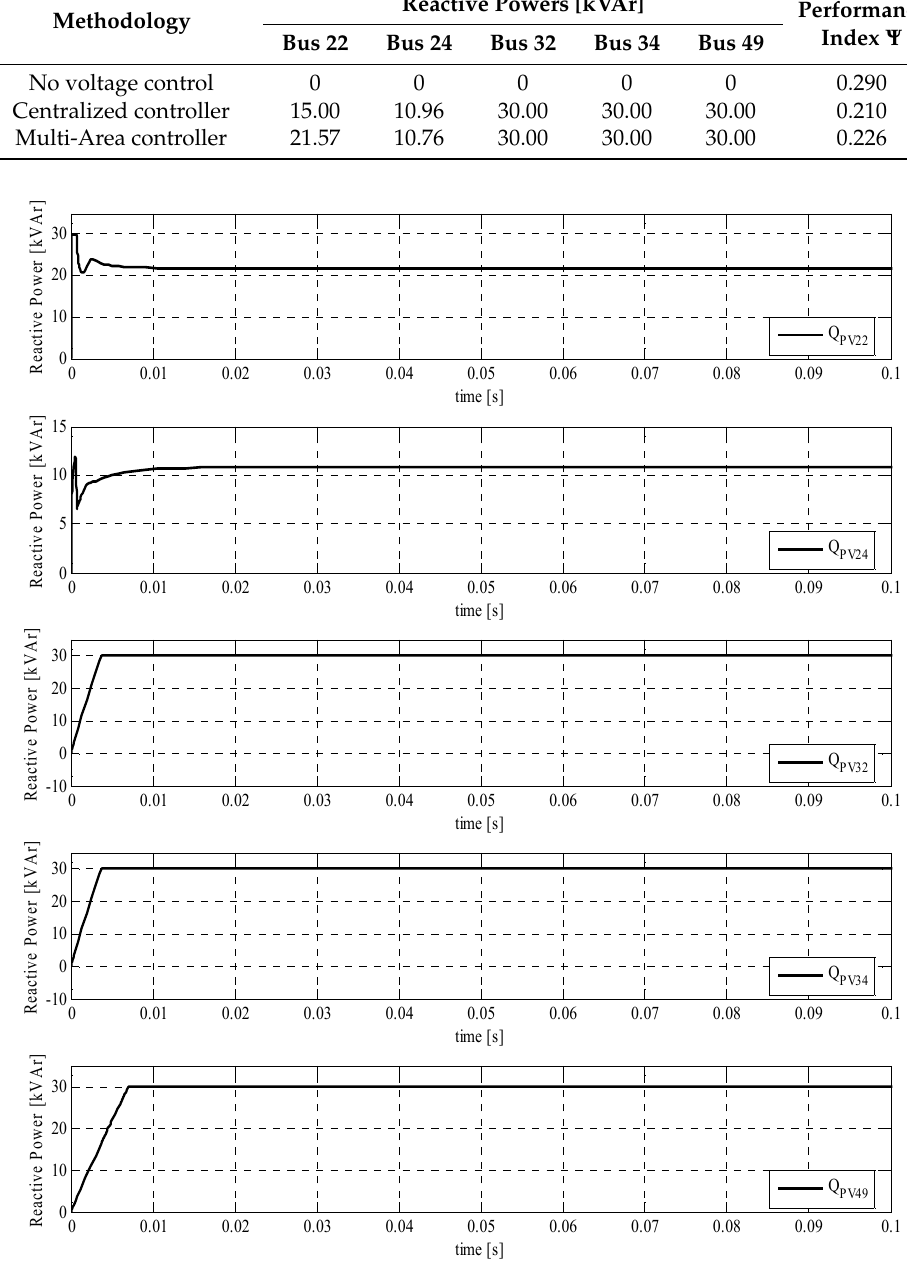
Figure 4. Reactive power control laws at the PV-inverters.